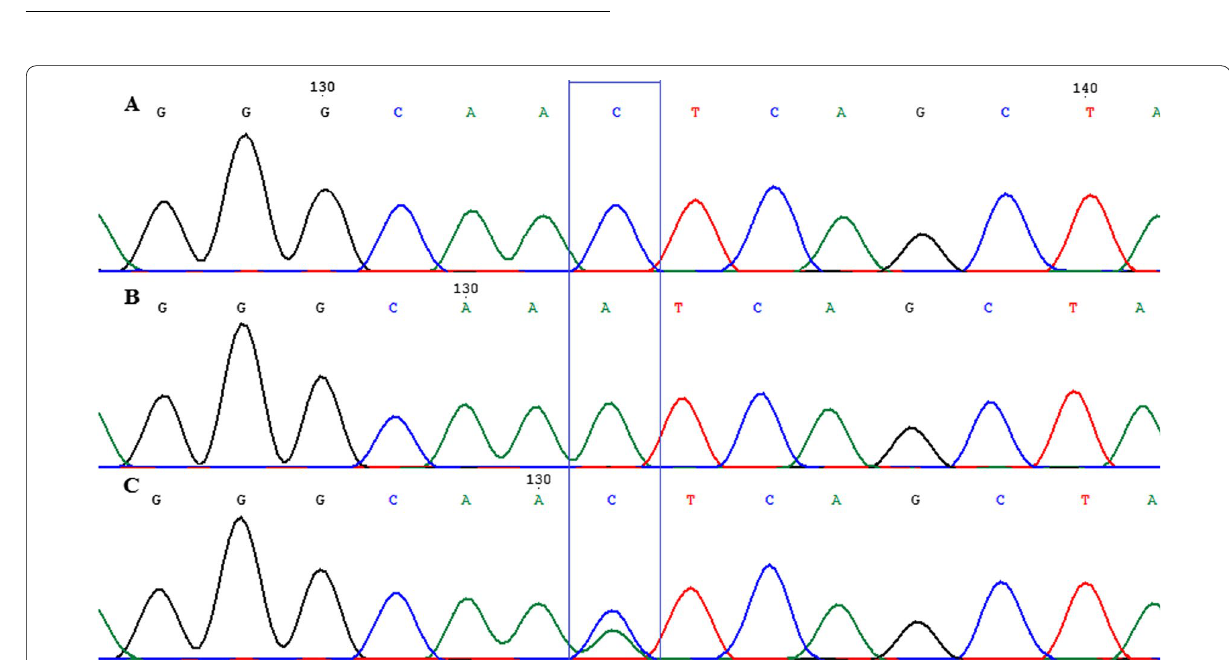
Fig. 1 ATRX gene Sanger sequencing result for the proband shows hemizygous genotype for mutant C allele ( A ), patient’s father is normal ( B ) and his mother is heterozygous ( C